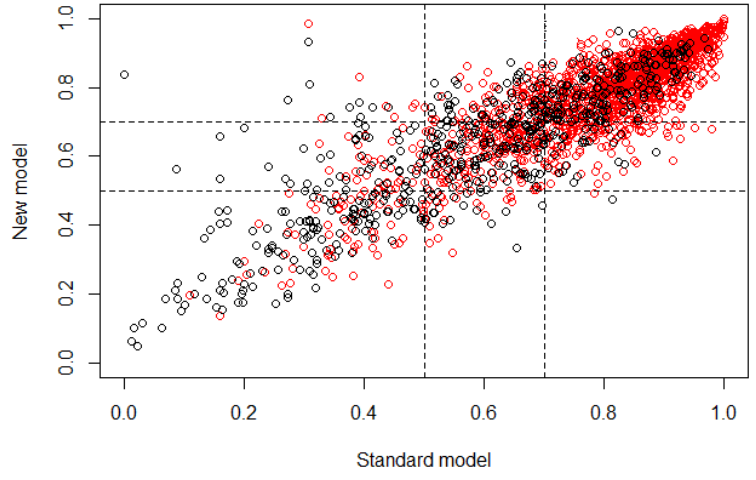
Figure 5. Plot of the risk category based on the NRI calculus for age group 4. The horizontal axis represents the standard model or the multivariate model before the feature selection, and the vertical axis represents the new model or the multivariate model after the feature selection (control ◦ , case ◦ ). Table 7. Reclassification table obtained for model 4 using NRI, 0.5 and 0.7 values represent the cutoff range used to calculate the risk category. Values in red represent true negatives, values in green represent true positives, and values in the cutoff range are presented in gray. False positives and false negatives are presented in black.